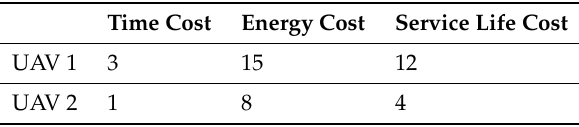
Table 4. Cost of UAVs by Task